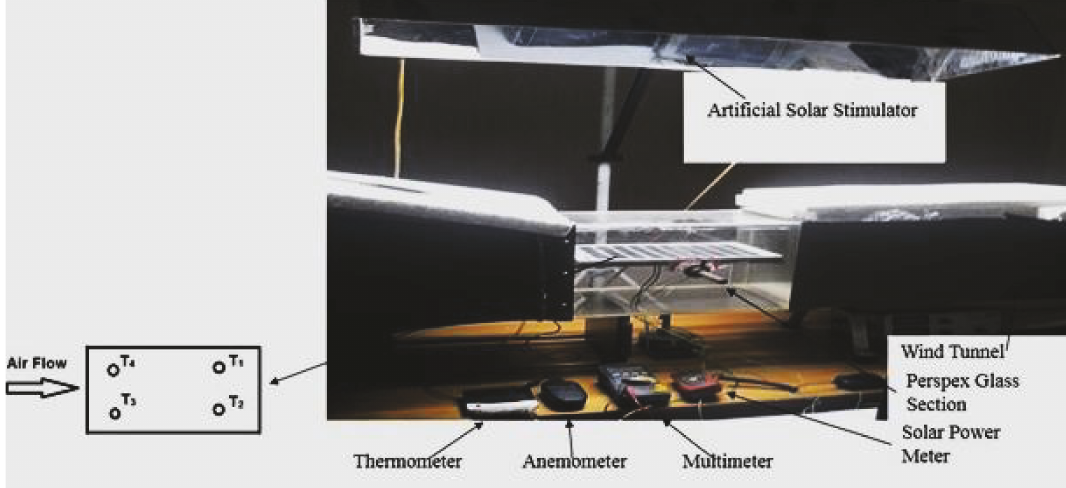
Figure 1: Schematic description of placement of thermocouples on PV module and the actual experimental setup in the wind